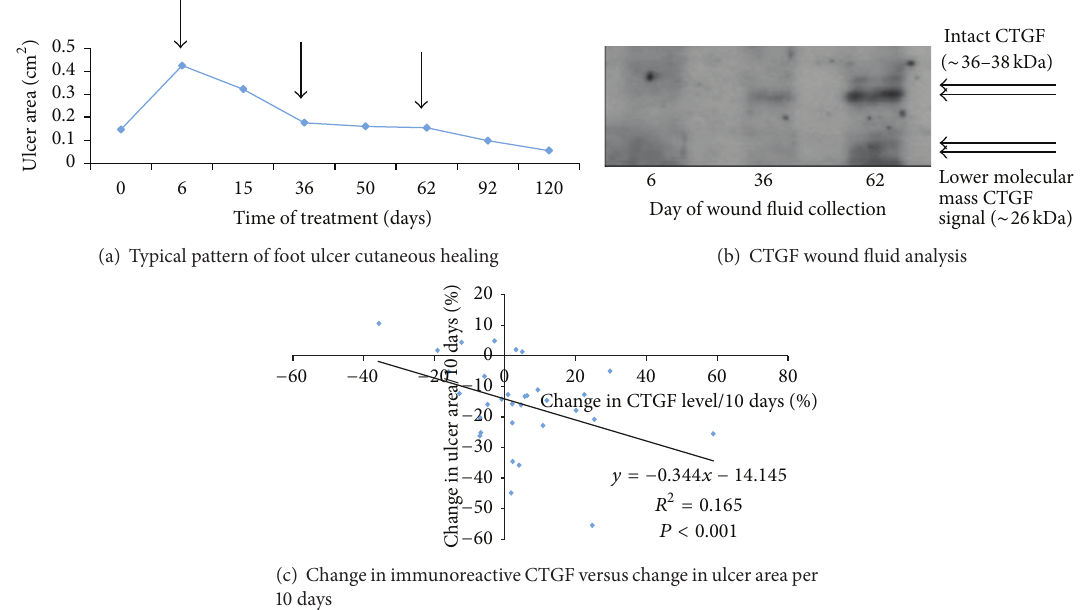
Figure 5: Endogenous ulcer fluid CTGF and diabetic foot ulcer healing. In (a) ulcer area versus time is shown for a typical small hallux plantar ulcer, with the arrows indicating sampling of postdebridement ulcer fluid. The ulcer fluid in (a) was analyzed by Western Immunoblot to detect CTGF immunoreactivity under nonreducing conditions, as shown in (b). Both intact monomeric CTGF and a lower molecular mass ∼ 26 kDa CTGF are observed. Images such as those in Figure 5(b) were quantitated by densitometry, to compare change in ulcer fluid CTGF immunoreactivity versus change in ulcer area, each across 10 days. In (c), CTGF was found to increase as ulcer area reduced ( 𝑅 2 = 0.165 ; 𝑃 < 0.001